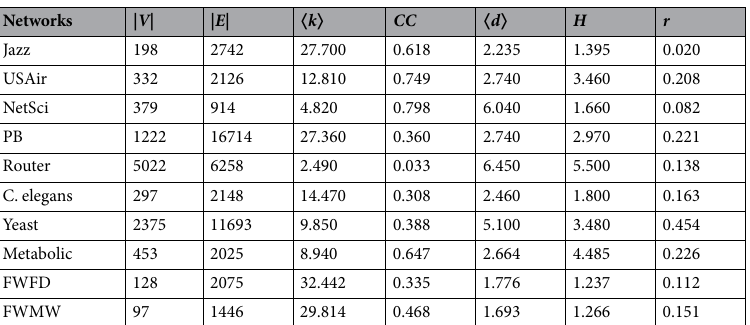
2 , and r is the assortative 2 k